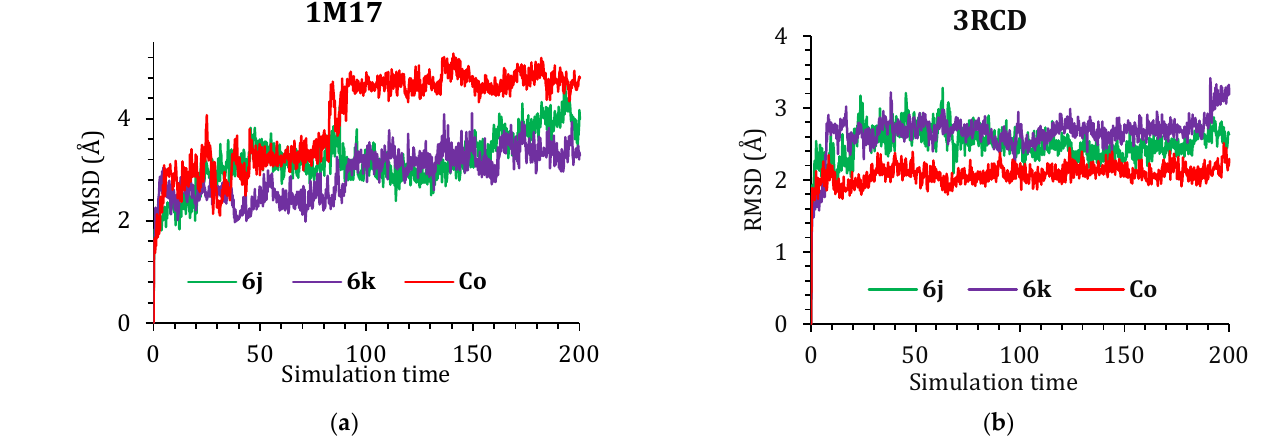
Figure 4. The RMSD of 6j , 6k , and Co-crystal ligand in complex with ( a ) 1M17 and ( b ) 3RCD.